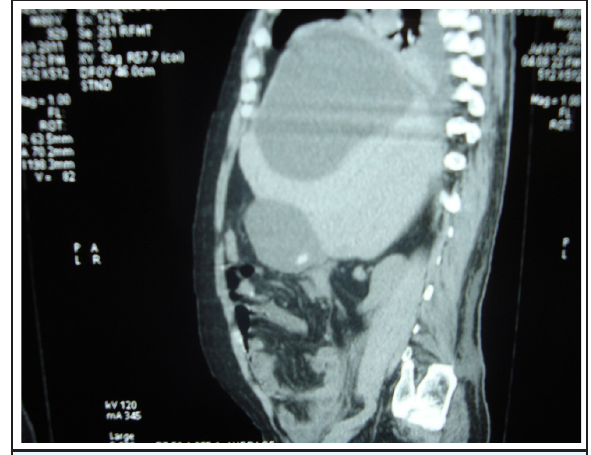
Figure 2. A sagittal image on CT scan revealing sub- capsular collection along superior surface of liver (A small gall stone evident along